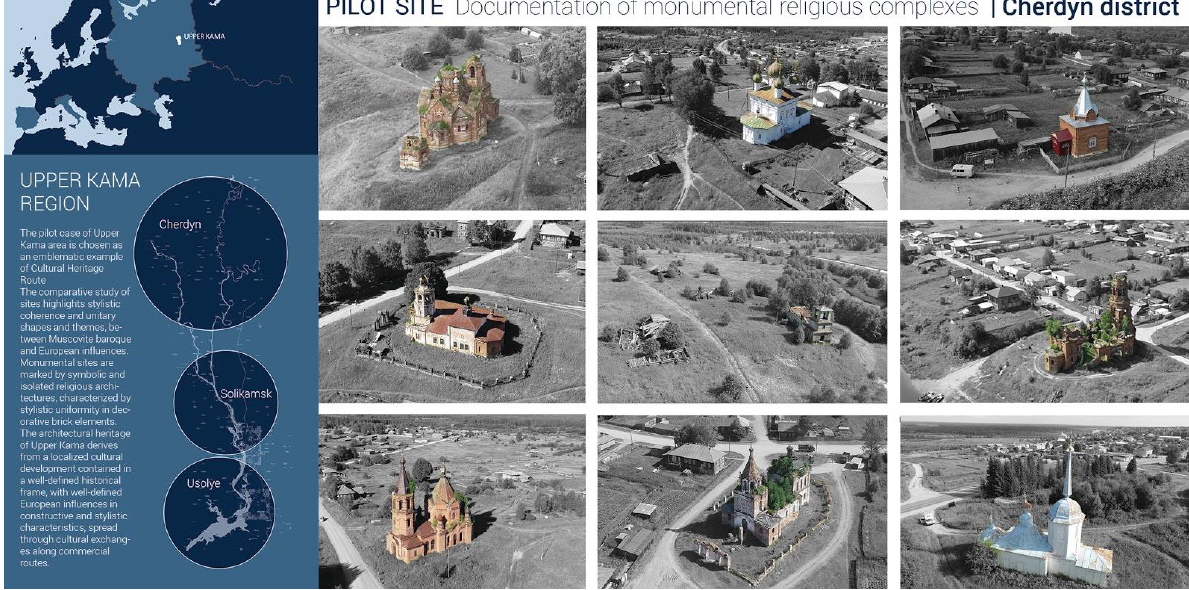
Figure 2. The territory of Upper Kama and its districts (Cherdyn, Usolye, Solikamsk). Some examples of types of churches and monumental sites found in the Cherdyn